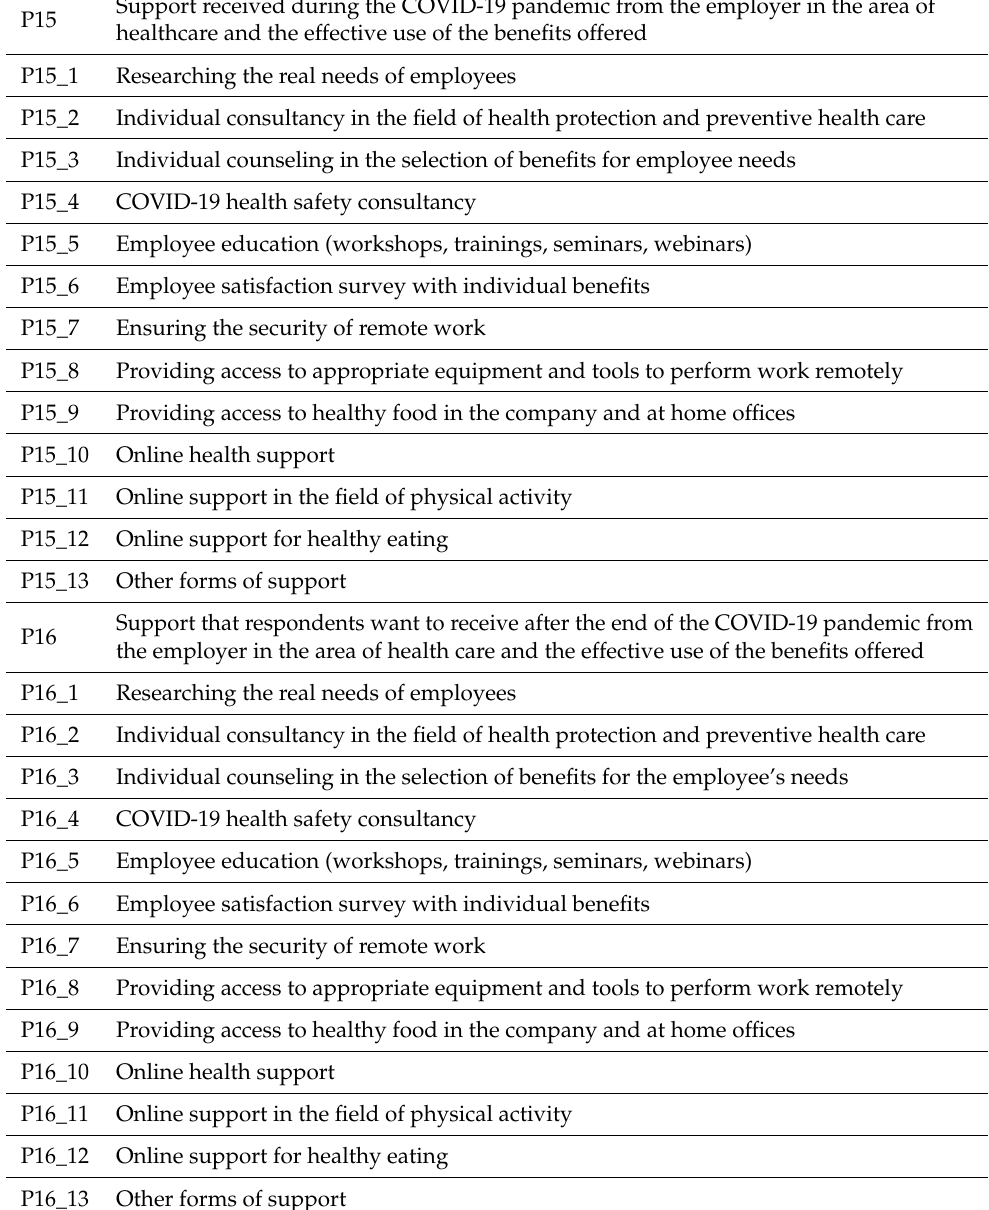
Table 1. Variables used in the analysis—received and desired support (0—no, 1—yes).